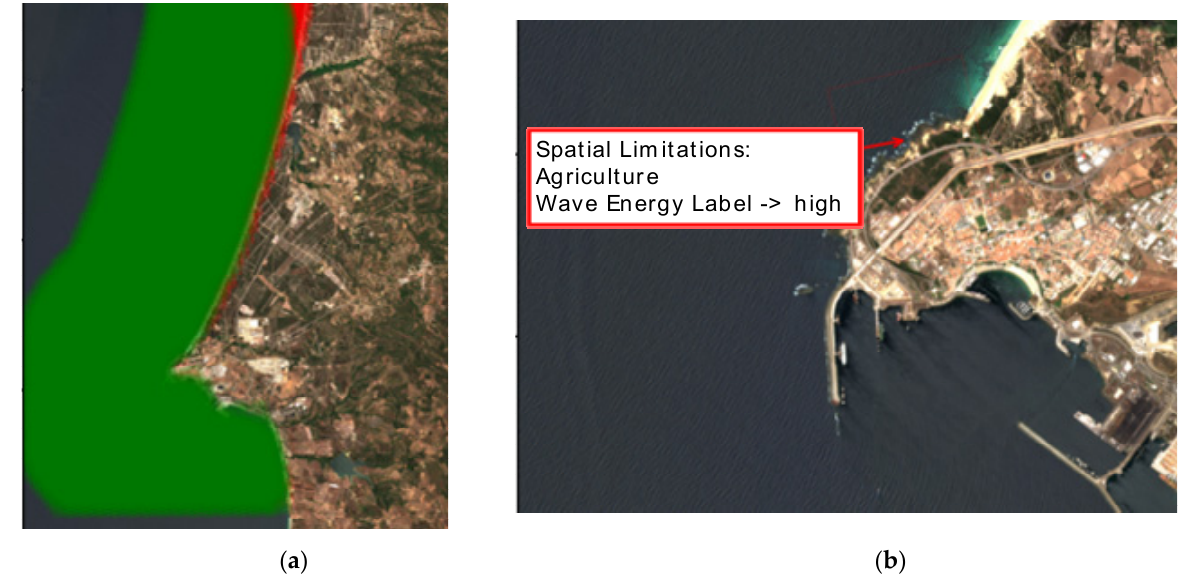
Figure 16. ( a ) Suitability map—Neural Network Predictions; ( b ) zoom to observe Multilabel Classification results.